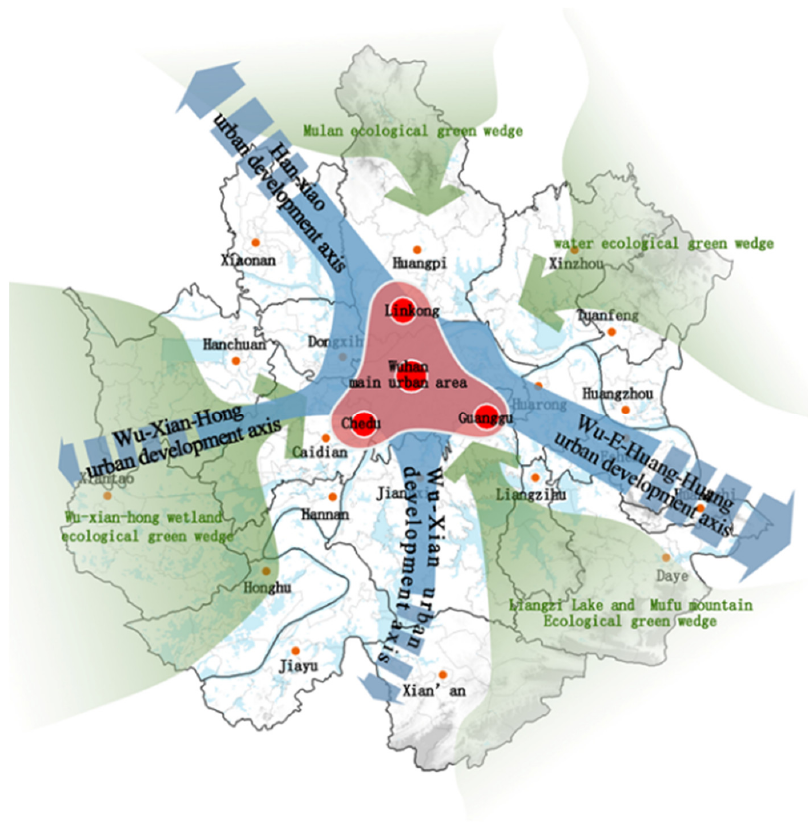
Figure 3. Spatial pattern of the Wuhan metropolitan